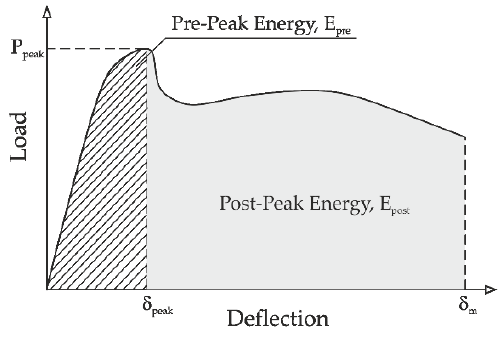
Figure 13. Pre-peak and post-peak strength analysis of fibre reinforced concrete slab.